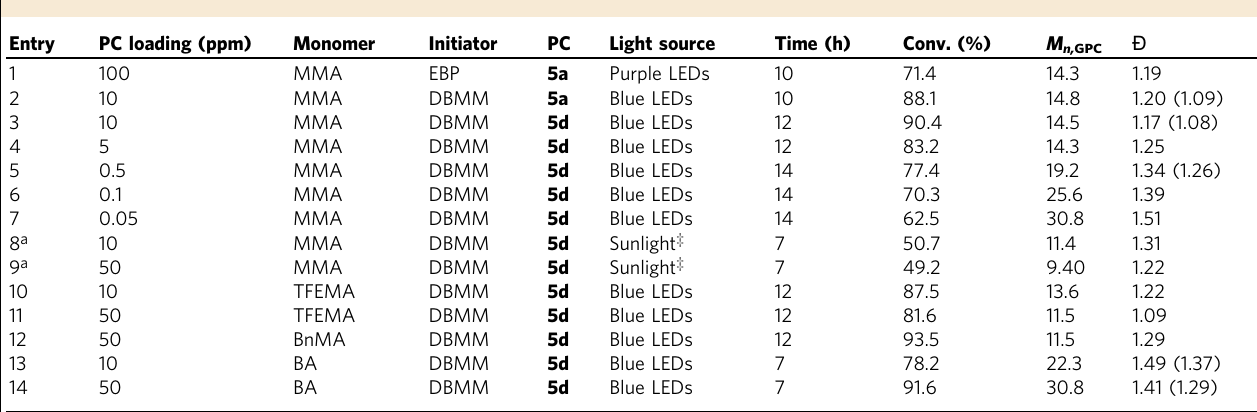
Fig. 4 Block polymer preparation. a Chain-extension from a PMMA macro-initiator (black) to produce block copolymers after a further polymerization with MMA (green), BnMA (red), and BA (blue). b GPC traces of the corresponding polymers depicted in left by using the same color coded. BnMA benzyl methacrylate, BA butyl Table 2 Polymerization with low catalyst loadings.